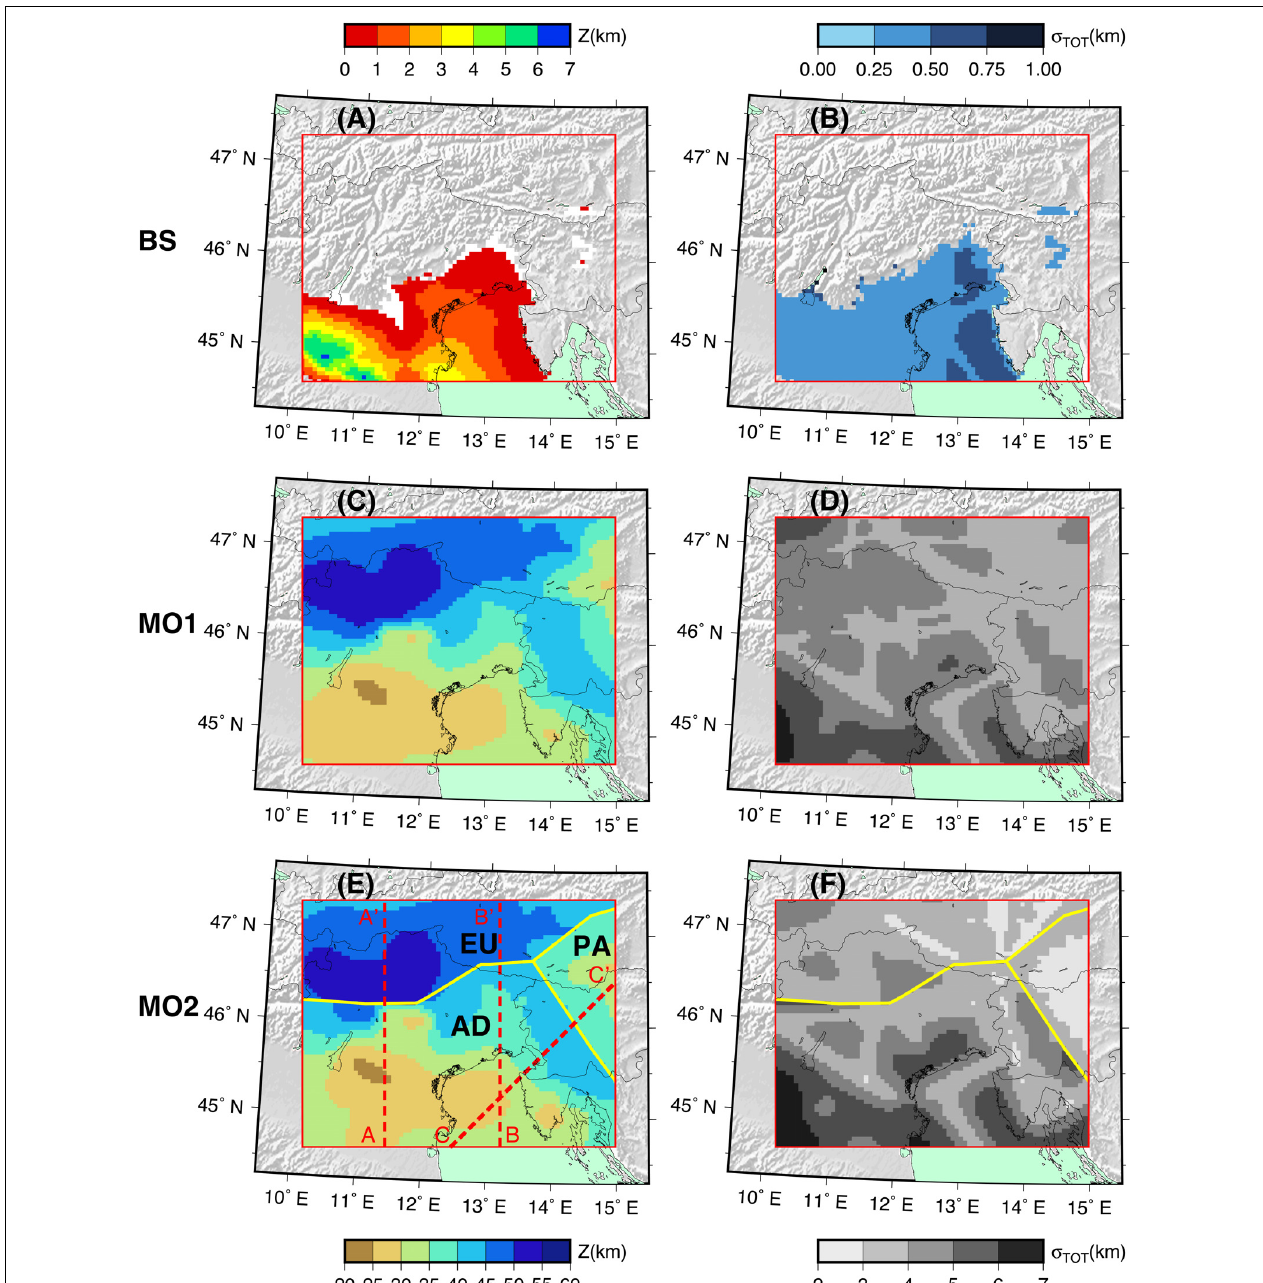
FIGURE 9 | Maps of the depth of the interfaces and their uncertainty. (A) BS interface, (B) BS uncertainties ( σ TOT ), (C) MO1 interface, (D) MO1 uncertainties ( σ TOT ), (E) MO2 interface, (F) MO2 uncertainties ( σ TOT ).